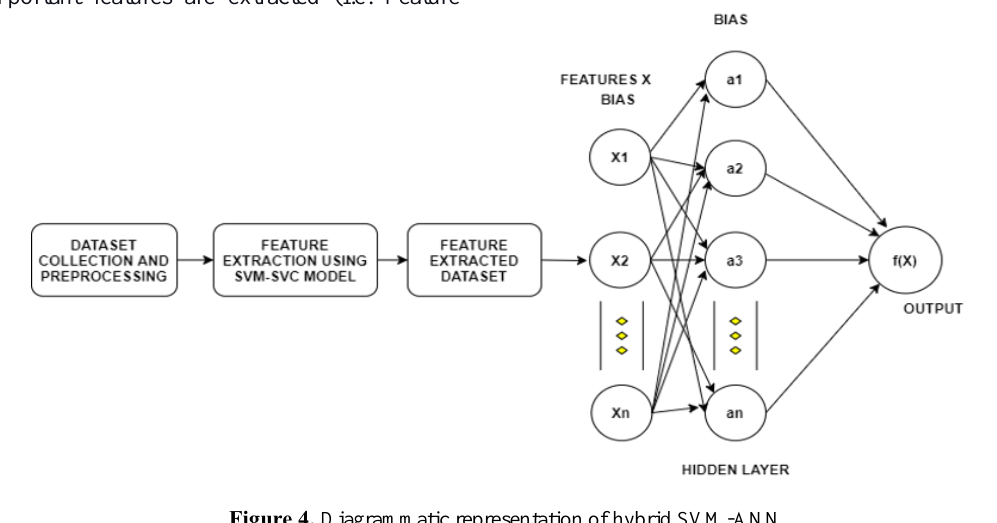
Figure 4. Diagrammatic representation of hybrid